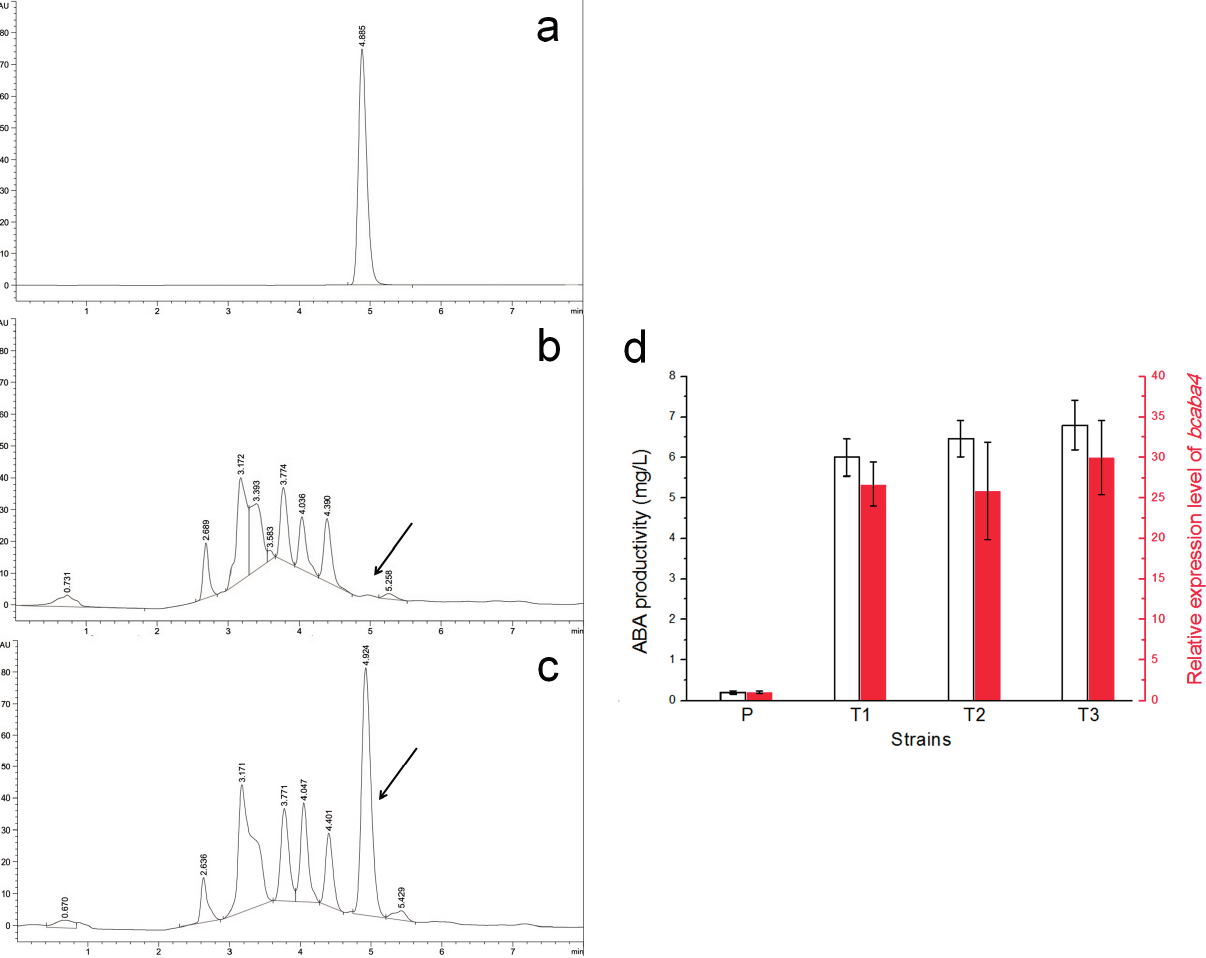
Figure 3. The expression vector pCBh1 expressed bcaba4 , a SM biosynthetic gene of B. cinerea , with high efficiency. ( a ) A commercial S -(+)-ABA was used as the standard sample; ( b ) the parent strain Bc-6 showed a pretty low absorption peak corresponding to ABA; ( c ) the representative transformant showed a significantly higher absorption peak corresponding to ABA. The absorption peaks corresponding to ABA are indicated by arrows; ( d ) ABA productivity and expression levels of bcaba4 in three randomly selected transformants are presented. The transformants were derived from ATMT of the B. cinerea wild type strain, Bc-6, using the expression vector pCBh1-ABA4. The expression levels of bcaba4 were determined by qRT-PCR and presented as percentage of the value obtained from the parent strain. P: the parent strain Bc-6; T1: a randomly selected transformant whose liquid chromatogram was shown ( c ); T2, T3: two other randomly selected